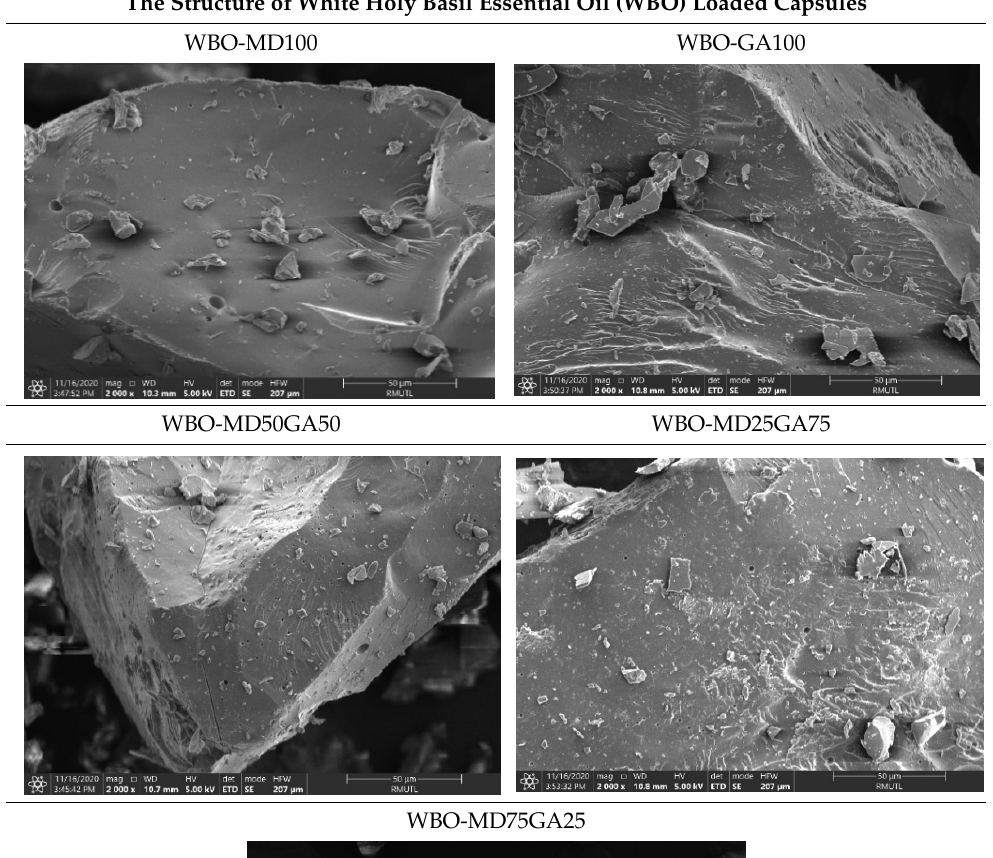
Table 6. Cont. The Structure of White Holy Basil Essential Oil (WBO) Loaded